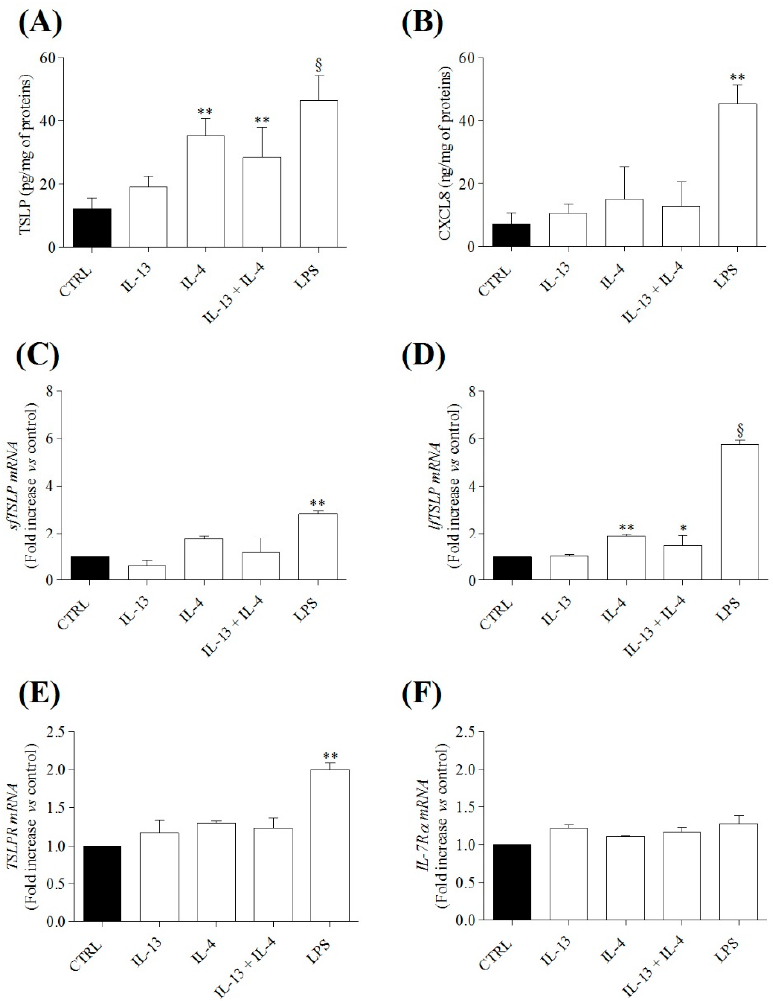
Figure 2. Effects of IL-13 and IL-4, alone or in combination, and of LPS on TSLP system in HLMs. Highly purified HLMs (1.5 × 10 5 cells/well) were incubated (16 h, 37 ◦ C) in the absence (CTRL) or in the presence of IL-13 (10 ng/mL), IL-4 (10 ng/mL) or their combination, or LPS (100 ng/mL ( A , B ). At the end of incubation, TSLP ( A ) and CXCL8 ( B ) proteins in supernatants were evaluated by ELISA. In parallel experiments, HLM (4.5 × 10 6 cells/well) were incubated (6 h, 37 ◦ C) in the absence (CTRL) or in presence of IL-13 (10 ng/mL), IL-4 (10 ng/mL) or their combination, or LPS (100 ng/mL). At the end of incubation, sfTSLP ( C ), lfTSLP ( D ), TSLPR ( E ), and IL-7R α ( F ) mRNAs were determined by quantitative RT-PCR. Data are mean ± SD of 6 independent experiments obtained from different patients. * p < 0.01, ** p < 0.001 and § p < 0.0001 vs.